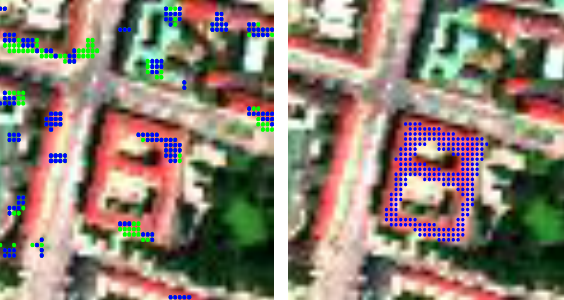
Figure 3: Left: The seed points selected from CartoSat DSM with removed vegetation and small regions (all points)